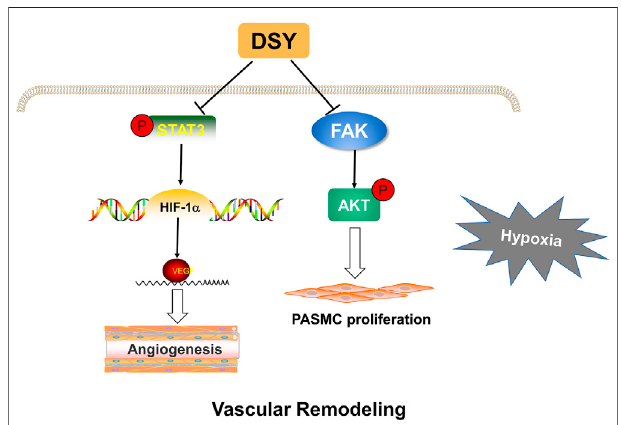
FIGURE 7 | Proposed mechanisms of DSY against hypoxia-induced pulmonary hypertension. DSY inhibits STAT3/HIF-1 α /VEGF pathway, thereby inhibiting pulmonary angiogenesis. DSY suppresses PASMC proliferation through FAK/AKT